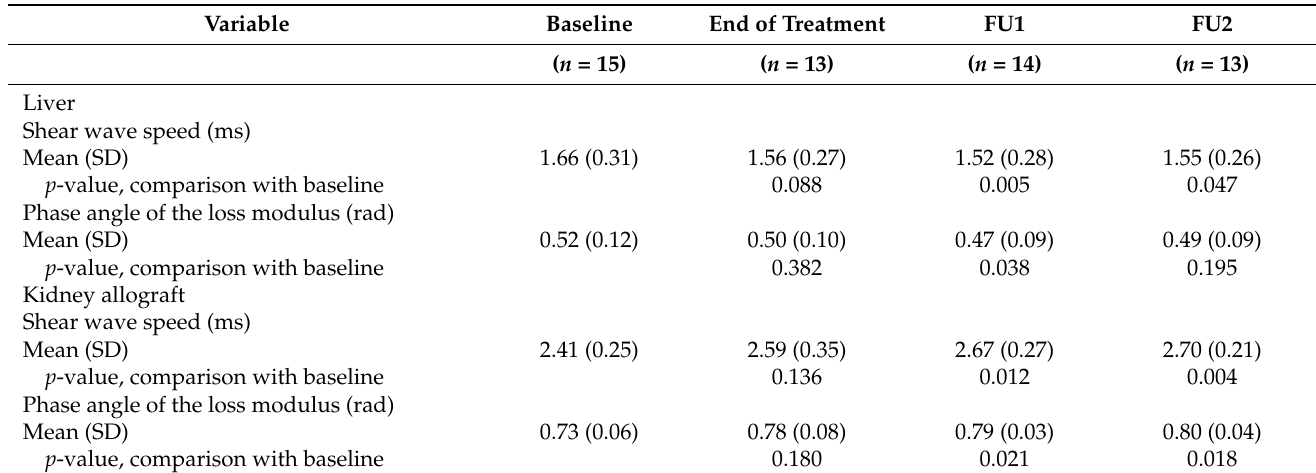
Table 3. Multifrequency MRE.